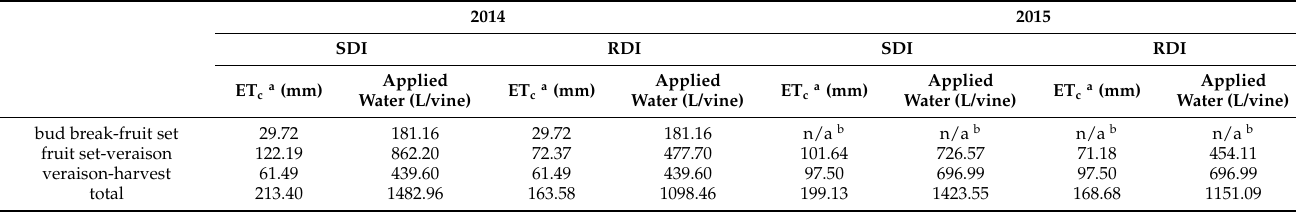
Table 1. Crop evapotranspiration (ET c ) and applied water amount between two irrigation regimes in a Merlot vineyard in Denair, California in 2014 and 2015.